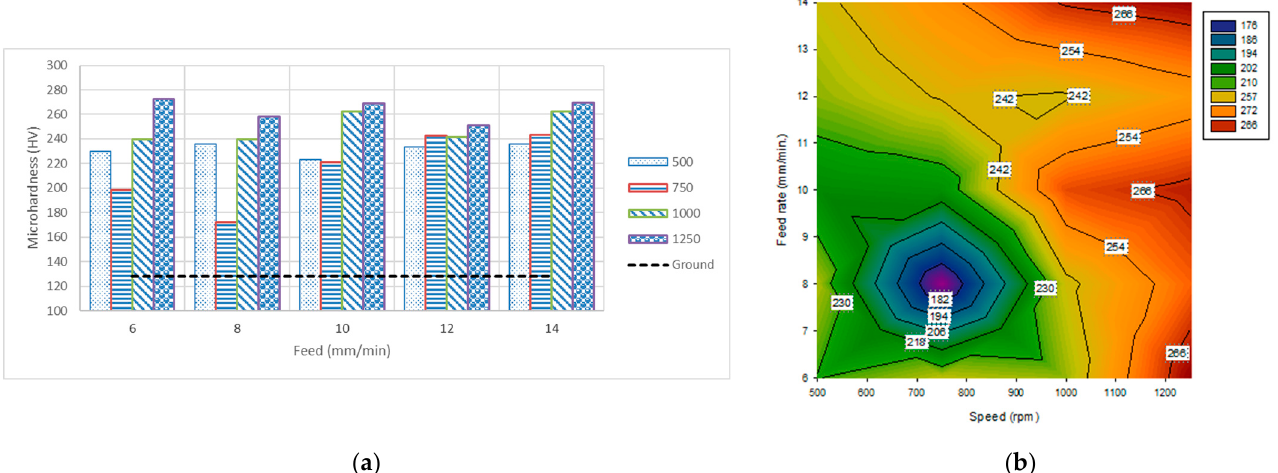
Figure 4. Average values of microhardness for various hardening speeds and feed rates. ( a ) Bar chart and ( b ) contour.